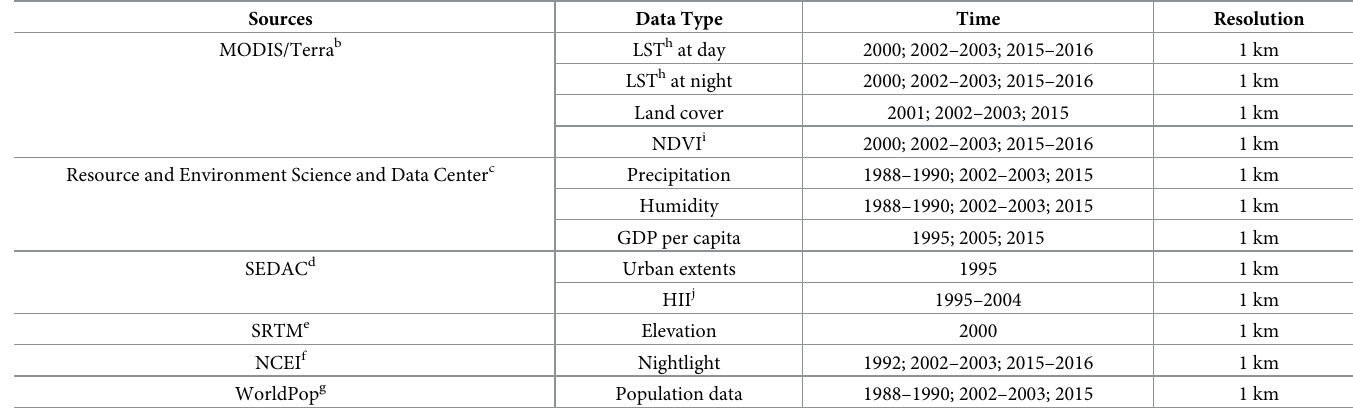
Table 1. Climatic, demographic and environmental data sources a